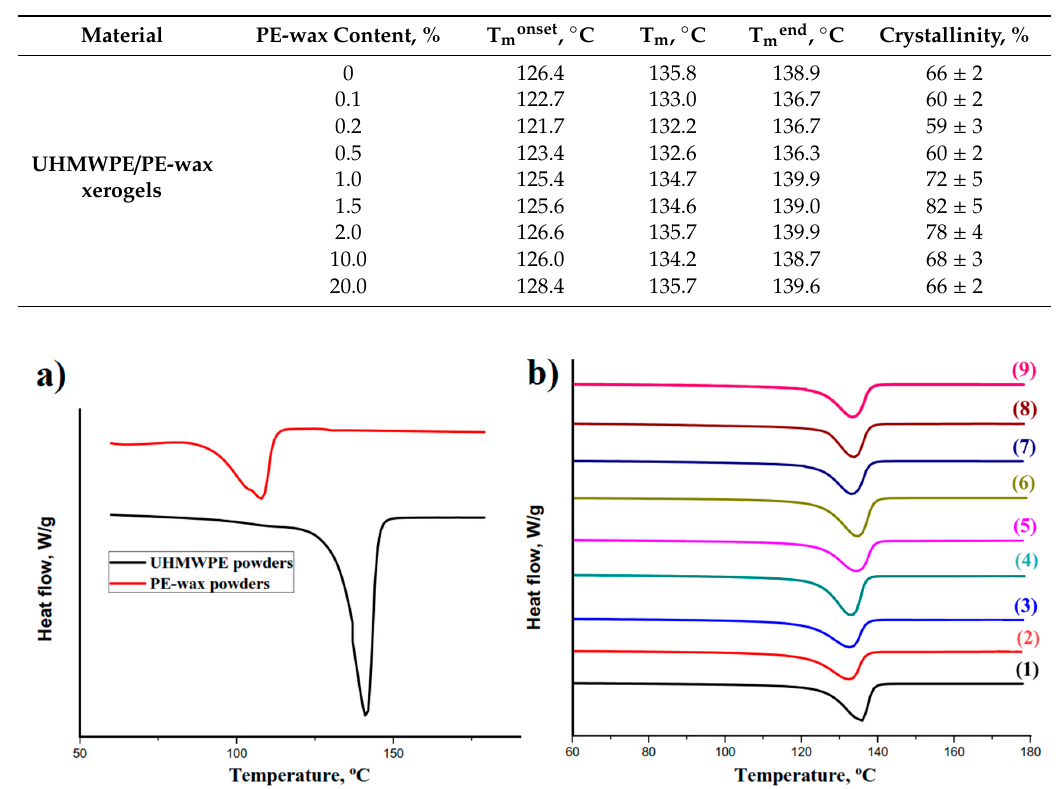
Figure 3. DSC curves for the UHMWPE / PE-wax: ( a ) powders, ( b ) xerogels with PE-wax contents: (1) 0% (virgin UHMWPE), (2) 0.1%, (3) 0.2%, (4) 0.5%, (5) 1.0%, (6) 1.5%, (7) 2.0%, (8) 10.0% and (9) 20.0%. Table 2. DSC test results for the UHMWPE and PE-wax powders (± the standard deviation).